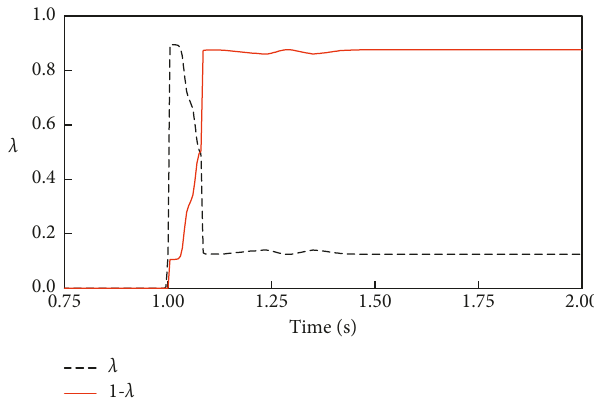
Figure 10: Coefficient λ and the complement 1 − λ in tip-in process.